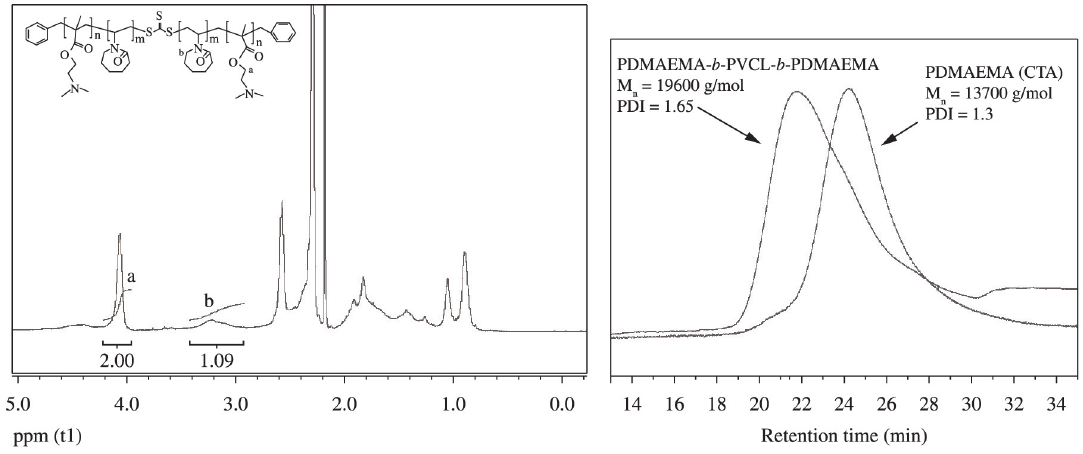
Figure 2. 1 H NMR spectrum for the triblock copolymer PDMAEMA -b -PVCL- b -PDMAEMA (left) and SEC traces of PDMAEMA (MCTA) and PDMAEMA -b -PVCL- b -PDMAEMA (right).